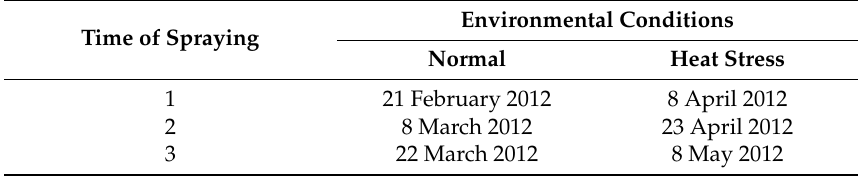
Table 5. Spraying dates of chamomile by salicylic acid under normal and heat stress conditions. Environmental Conditions Time of Spraying